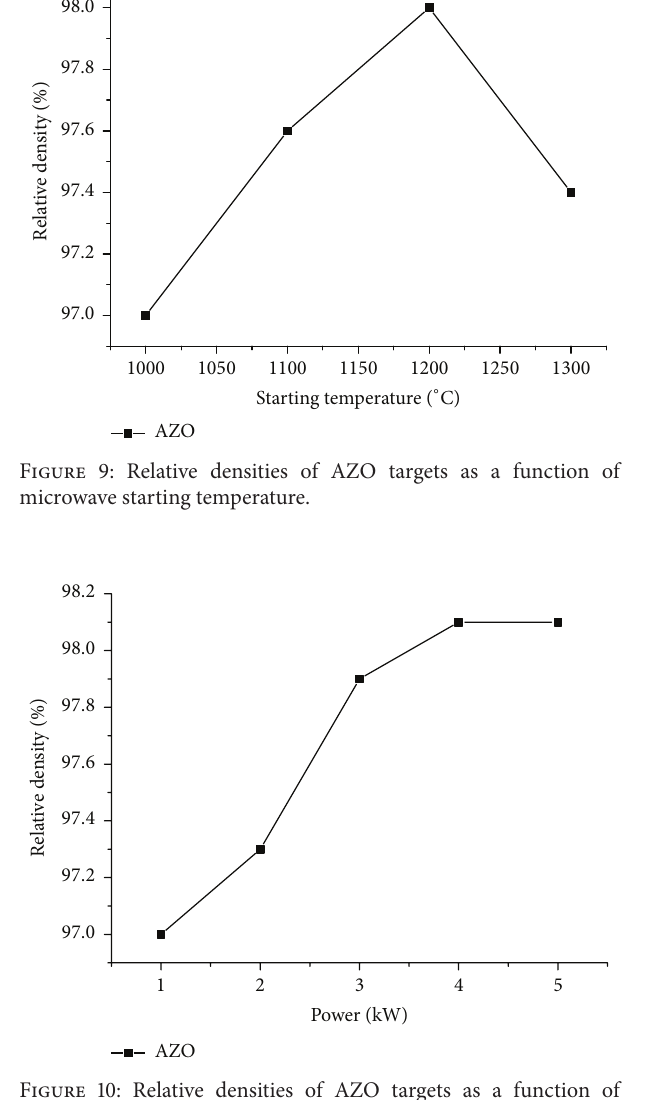
Figure 10: Relative densities of AZO targets as a function of microwave power.